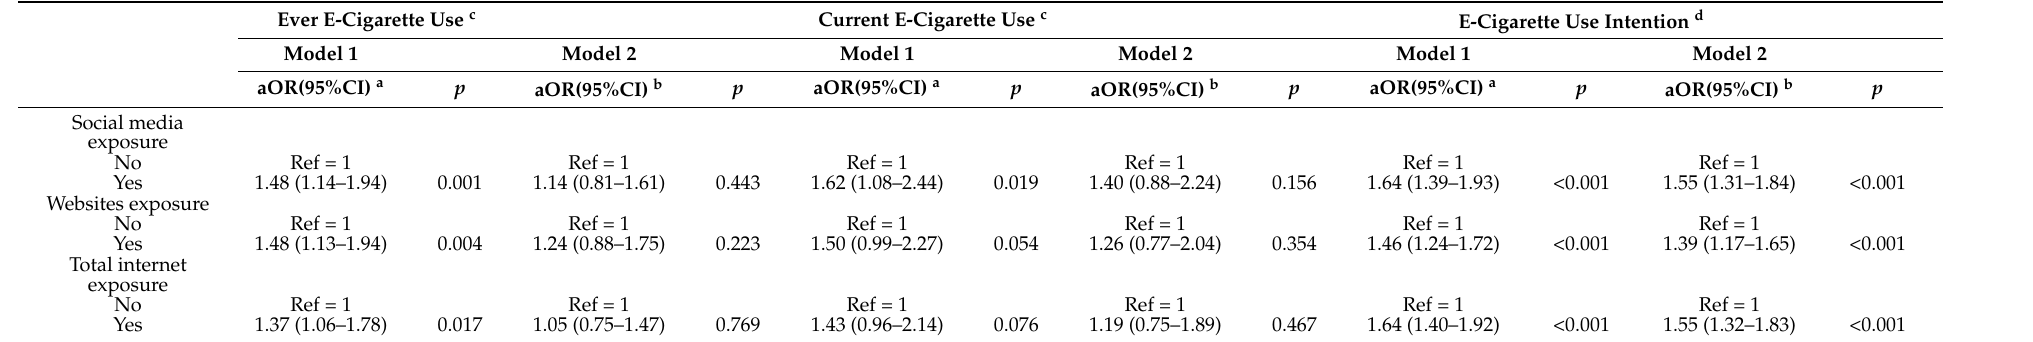
Table 3. Online e-cigarette information exposure and e-cigarette use risk among